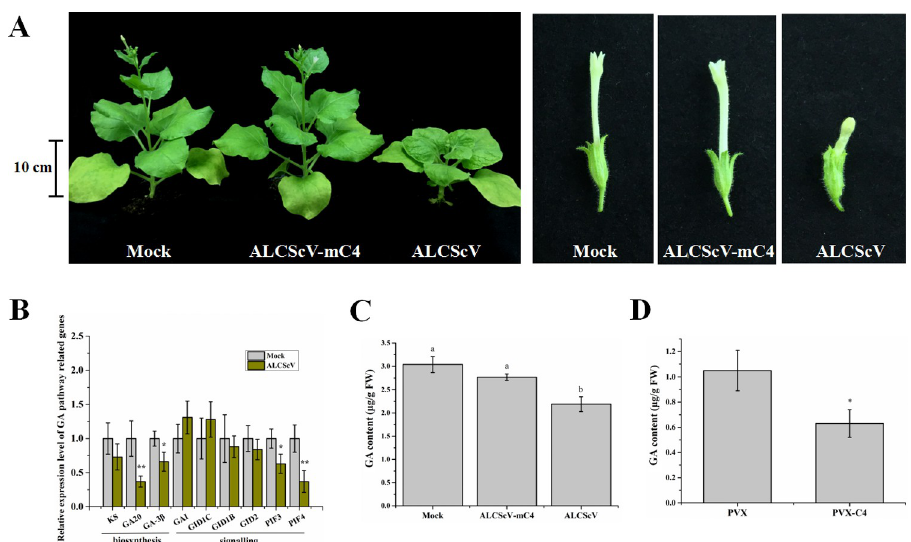
Fig 1. ALCScV infection influences the gibberellin (GA) pathway in N . benthamiana plants. (A) Photographs of the mock-, ALCScV- and ALCScV-mC4-inoculated N . benthamiana plants taken at 28 dpi. The results were reproduced in three independent experiments using 10 plants per treatment. (B) qRT-PCR analyses of the relative expression of GA pathway-associated genes in mock- or ALCScV-inoculated N . benthamiana plants. �� indicates a significant difference between the two treatments at the P < 0.01 level by Student’s t -test; � indicates a significant difference between the two treatments at the P < 0.05 level. These experiments were performed with three independent biological replicates with similar results. (C) and (D) Results of HPLC analyses showing the contents of endogenous GA in the PVX-, PVX-C4-, mock-, ALCScV-, and ALCScV-mC4-inoculated N . benthamiana plants at 14 dpi, respectively. Different letters above the bars indicate significant differences ( P <